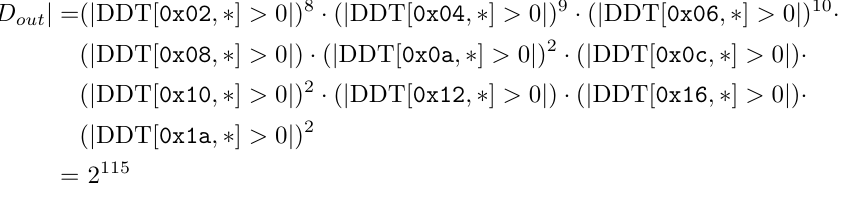
Table 12: Differential characteristic LB2. The probability of this characteristic is 2 − 8 . The breakdown of the probability (in − log